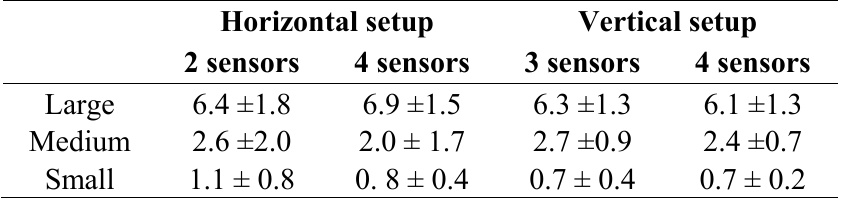
Table 3 . The mean and standard deviation calculated values of the moment for all configurations. Units are 100*A·m 2